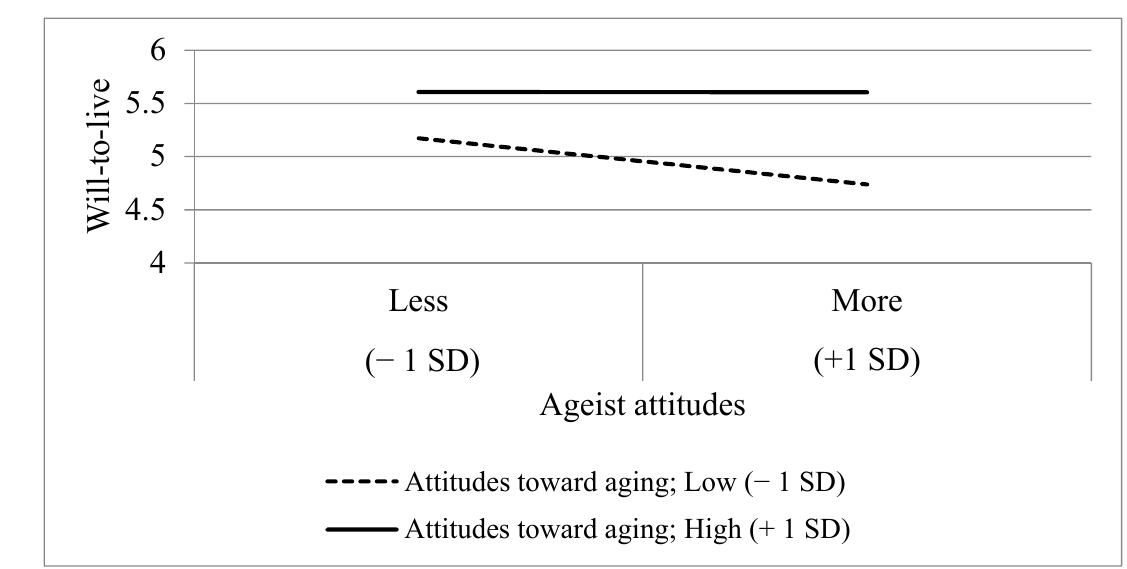
Figure 2. The two-way interaction between ageist attitudes and attitudes toward aging predicting WTL.